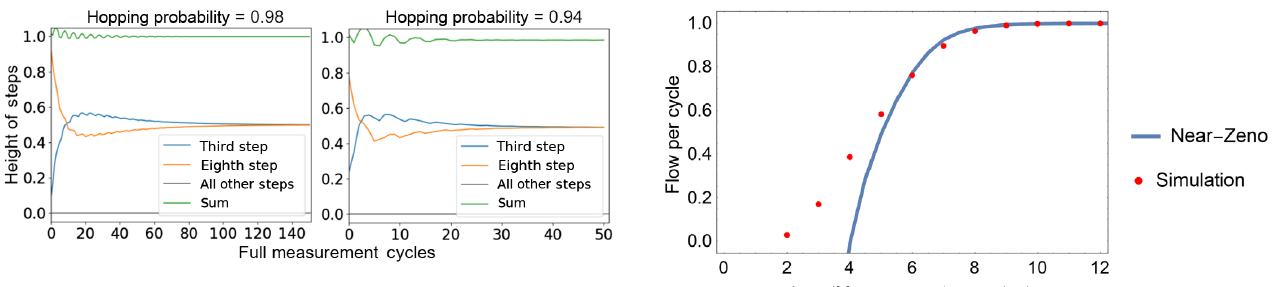
FIG. 9. Flow after each measurement step for hopping prob- abilities p ¼ 0 . 98 (left) and p ¼ 0 . 94 (right). Note that in the longtime limit, the third and eighth measurement step of both hopping probabilities converge to half the total flow per meas- urement cycle.